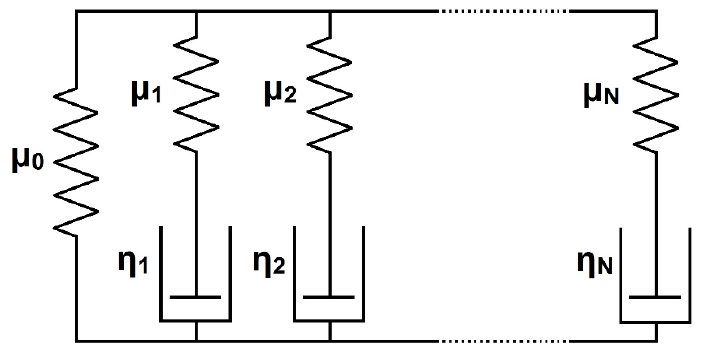
Figure 2. Generalized Maxwell rheological model with N Maxwell element chains.